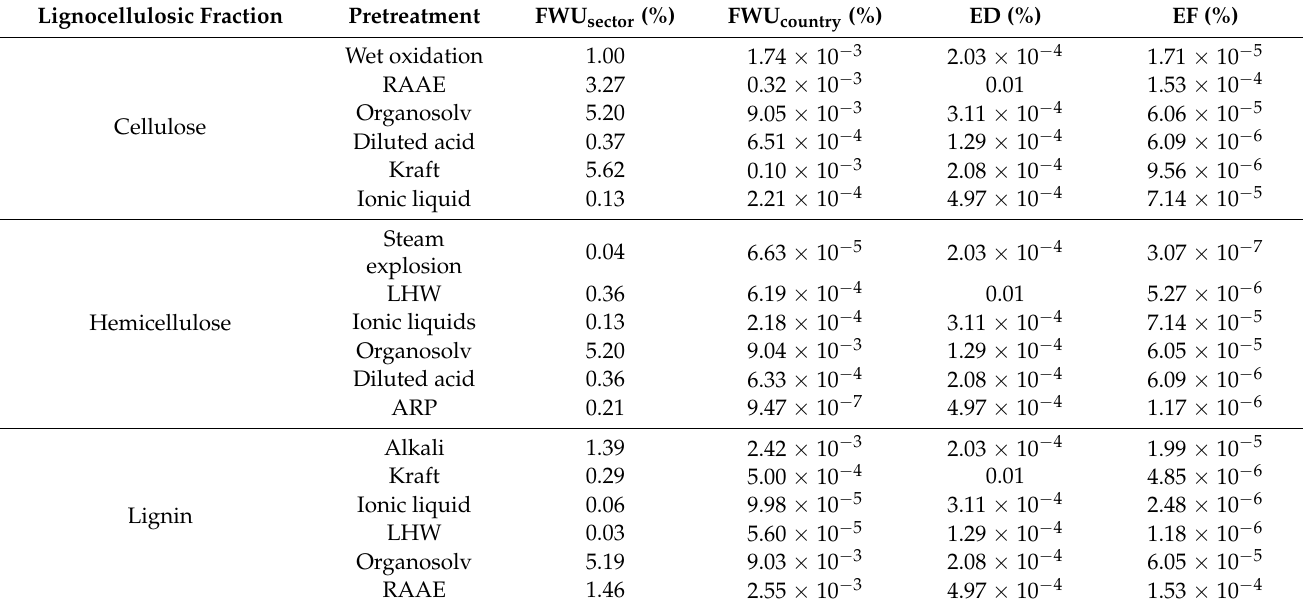
Table 6. Social indicator results of access to material resources adapted to the Colombian context. Lignocellulosic